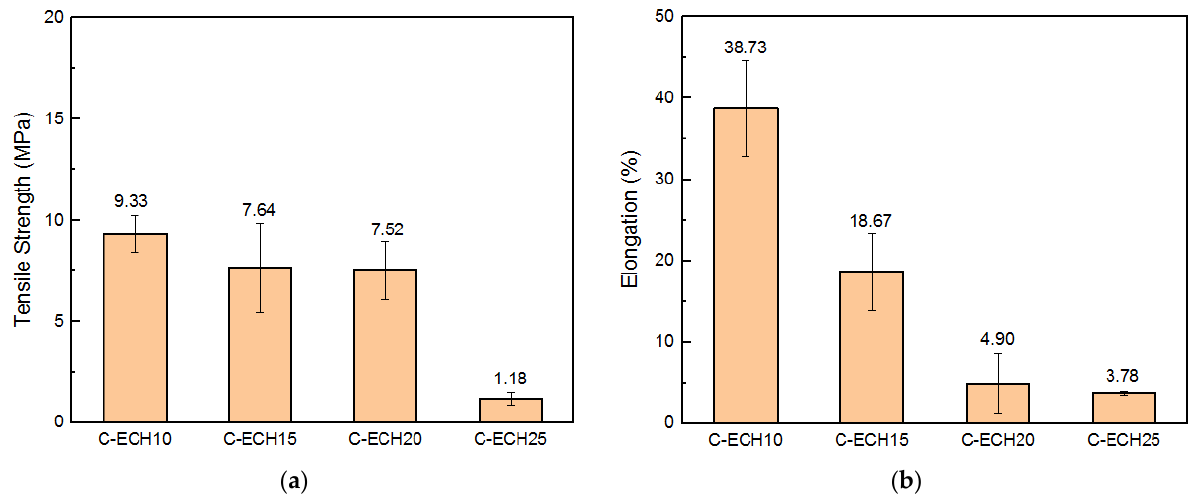
Figure 5. ( a ) Tensile strength and ( b ) elongation of the cellulose bioplastic samples at various ECH Figure 5. ( a )Tensilestrengthand( b )elongationofthecellulosebioplasticsamplesatvariousECHconcentrations. concentrations.